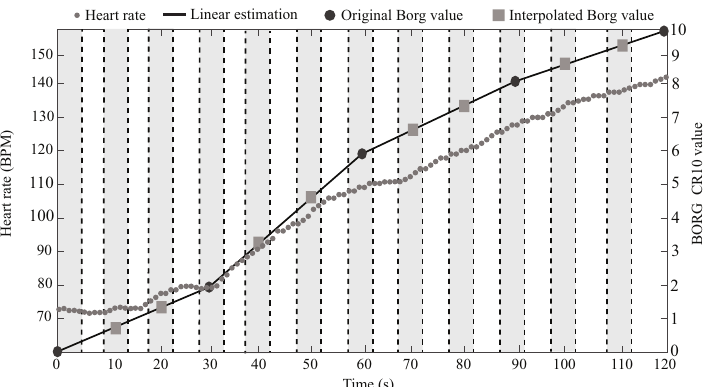
Figure 7. Selection of the five nearest sit-to-stand cycles to each Borg Value. Considering the importance of the heart rate for the patient’s fatigue monitoring in the rehabilitation programs, this parameter was incorporated into the data set as the feature number 33 (F33) in a similar way as the other features. As the Zephyr sample rate is 1 Hz, each test register contains 120 heart rate records. Hence, aiming to get an average value without repeating records, the mean values of the five closest heart rate measurements to each Borg value (except for the last one) were used to relate the fatigue level with this physiological parameter. Figure 8 presents an example of these heart rate record selections, represented by the dashed lines and the clear gray background.